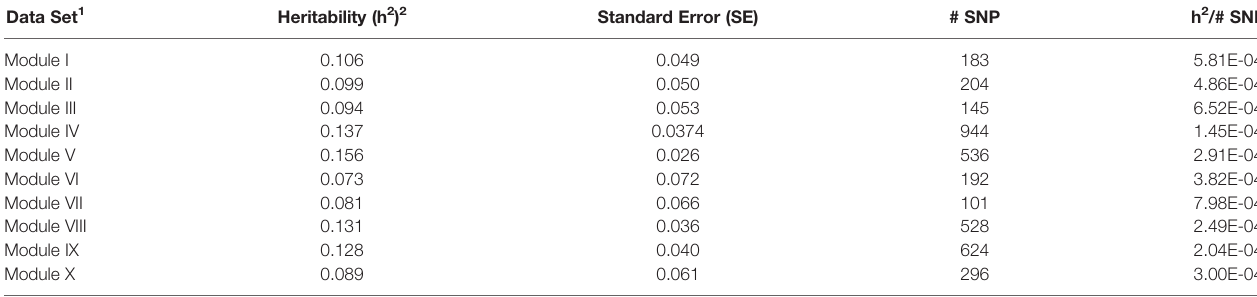
TABLE 6 | Heritability estimates for feed ef fi ciency from weighted genome-wide association studies (GWAS) utilizing SNP with weight > 5. Data Set 1